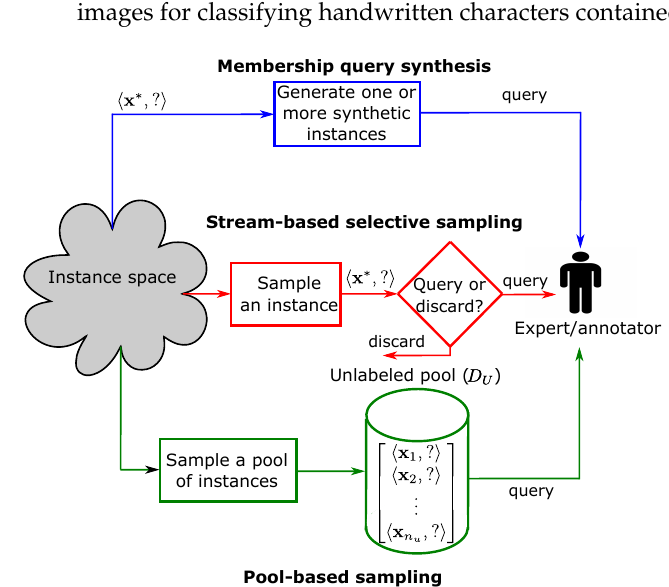
Figure 2. A comparison between AL’s three main